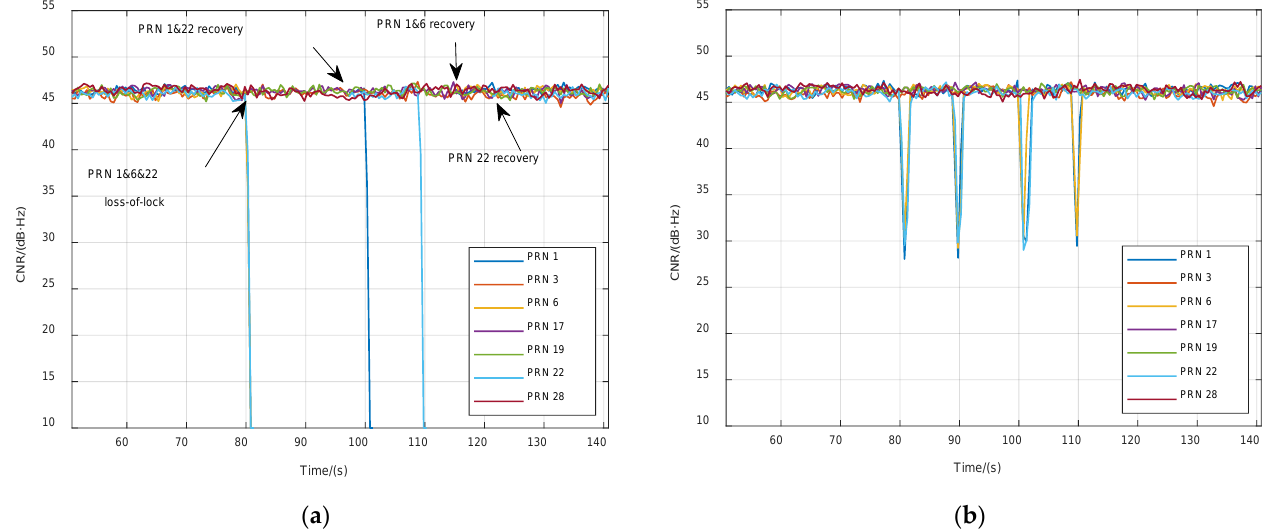
Figure 9. Carrier-to-noise ratio (CNR) of tracking satellites in ultrahigh-dynamic scenario. ( a ) Scalar tracking loop (STL); ( b ) vector tracking loop (VTL).